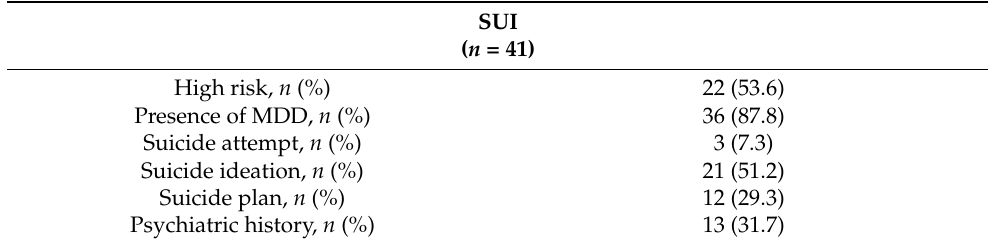
Table 1. Characteristics of subjects with